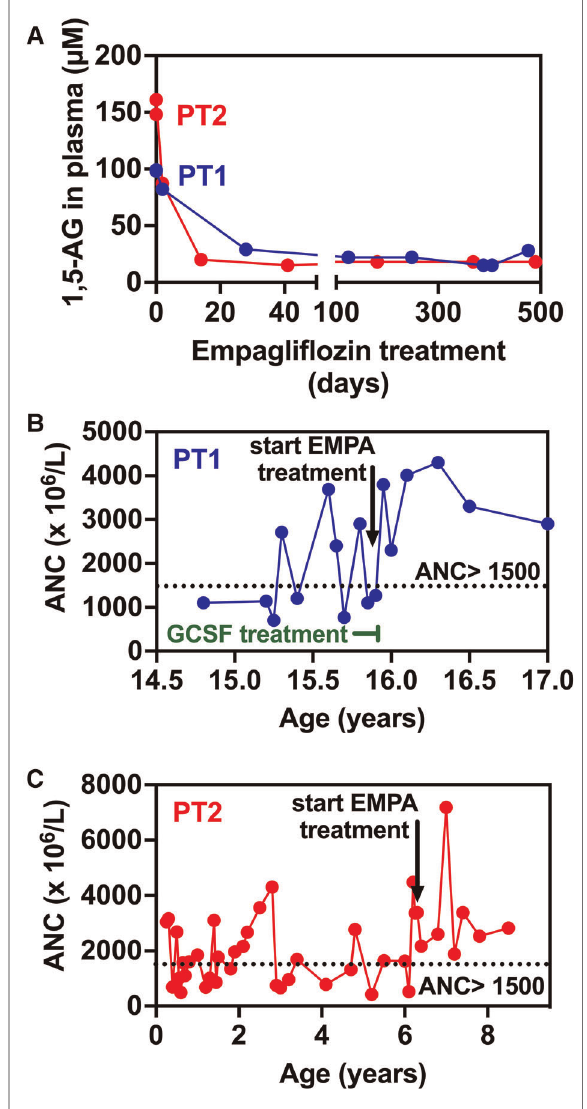
FIGURE 3 Evolution of 1,5-anhydroglucitol and neutrophils counts in blood before and during empagli fl ozin (EMPA) treatment for PT1 and PT2. ( A ) 1,5-AG present in plasma was measured by LC-MS analysis in blood samples from PT1 and PT2 taken before and during treatment. ( B,C ). The time-line shows that in the case of both patients, following the initiation of EMPA treatment, ANC remain above 1,500×10 6 /l (despite the end of GCSF treatment in PT1 — panel B) indicating the absence of neutropenia episodes (ANC<1,500×10 6